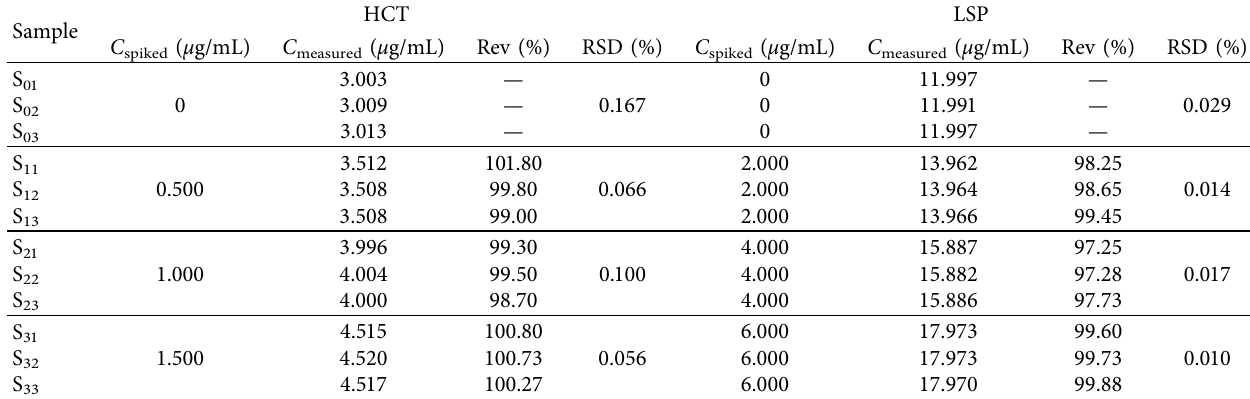
Table 3: Recovery of HCT and LSP in Splozarsin Plus.